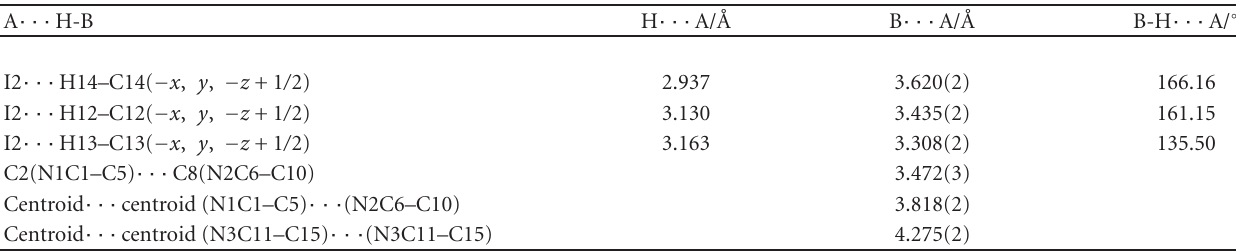
Table 3: Intermolecular interactions in crystals of [Cd(Cltpy)I 2 ] complex.